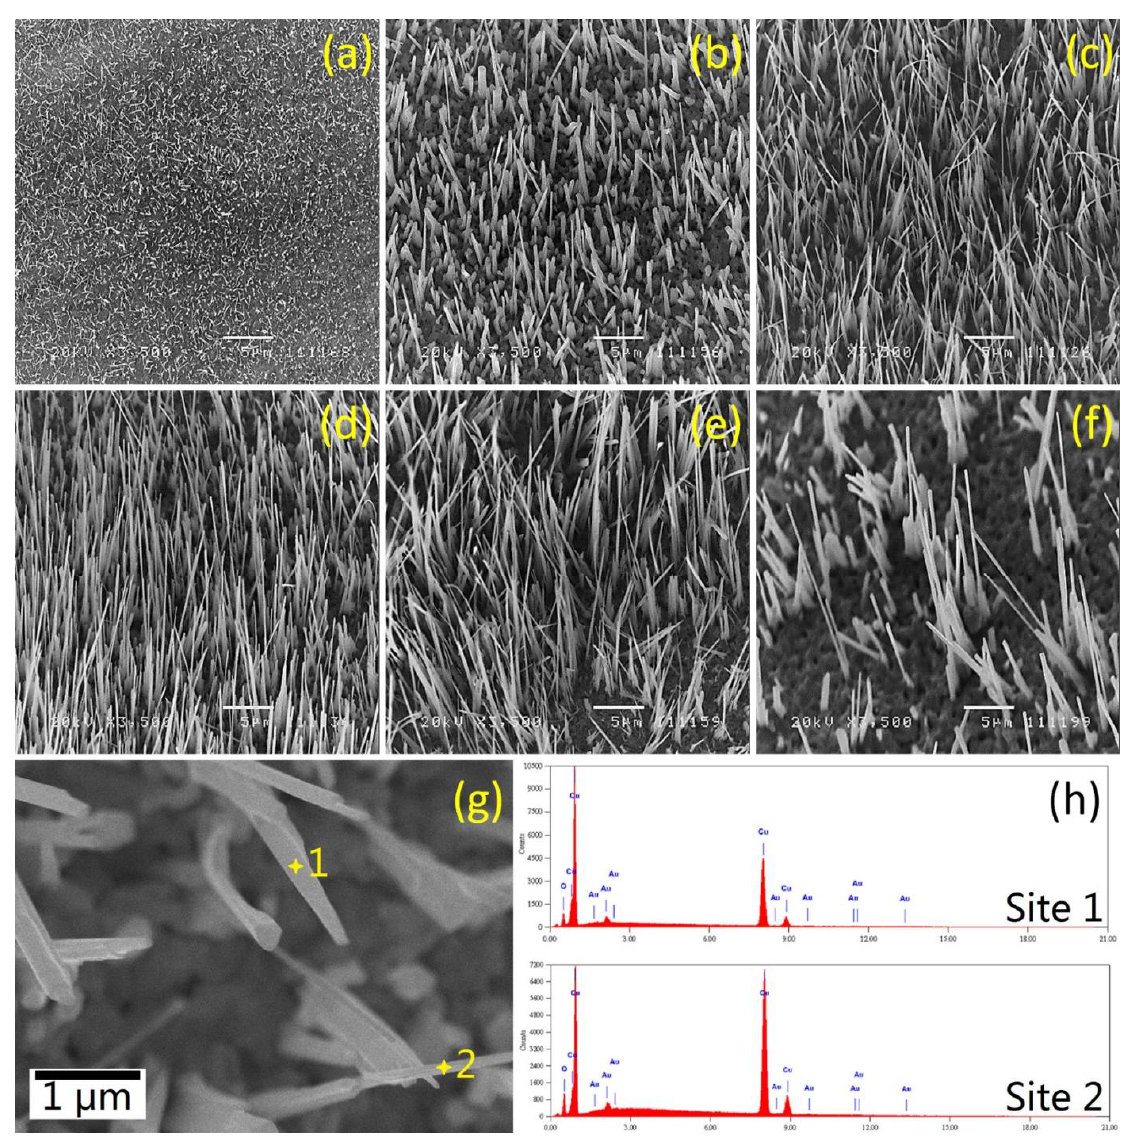
Figure 3. SEM images of ( a ) CuO-400, ( b ) CuO-500, ( c ) CuO-550, ( d ) CuO-600, ( e ) CuO-650 and ( f ) CuO-700; ( g ) magnified SEM image of CuO-600 and ( h ) the corresponding XEDS spectra for the two spot sites labelled in ( g